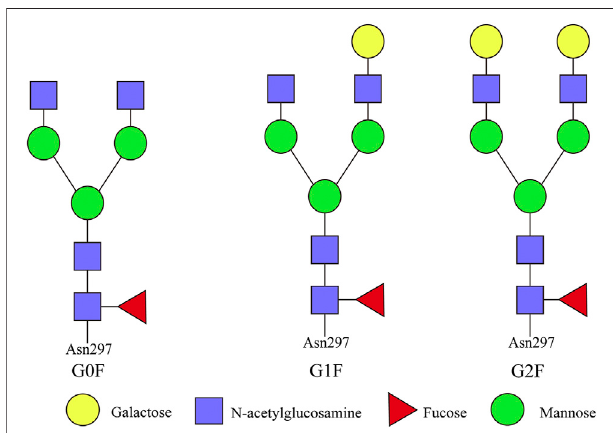
FIGURE 4 | Types of glycosylation modi fi cation of recombinant antibodies. The representative N-glycan structures identi fi ed on antibody Fc fragment are G0F, G1F, and G2F. G0F: asialo, agalactose, biantennary complex, core substituted with fucose; G1F: asialo,